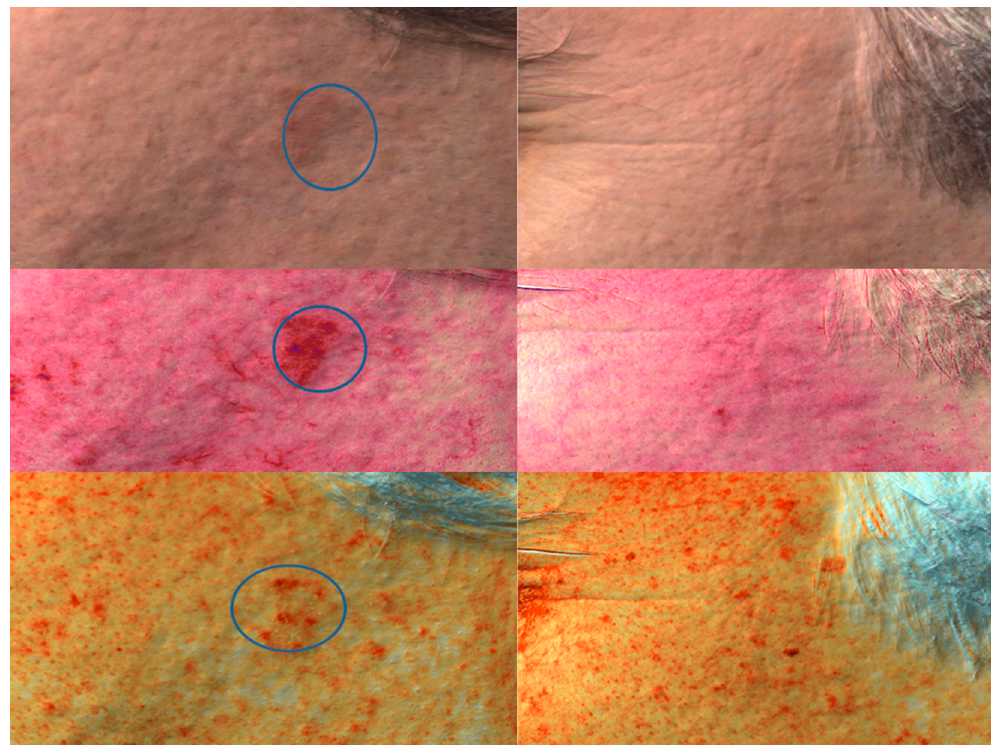
Figure 4. Antera three-dimensional hemoglobin and melanin distribution of AK KIN I before and after one DL-PDT treatment (three months later).